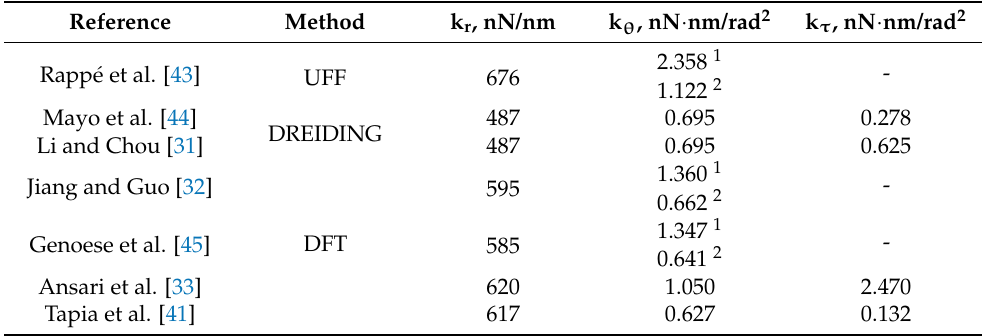
Table 2. Bond force constants for BN nanostructures reported in the